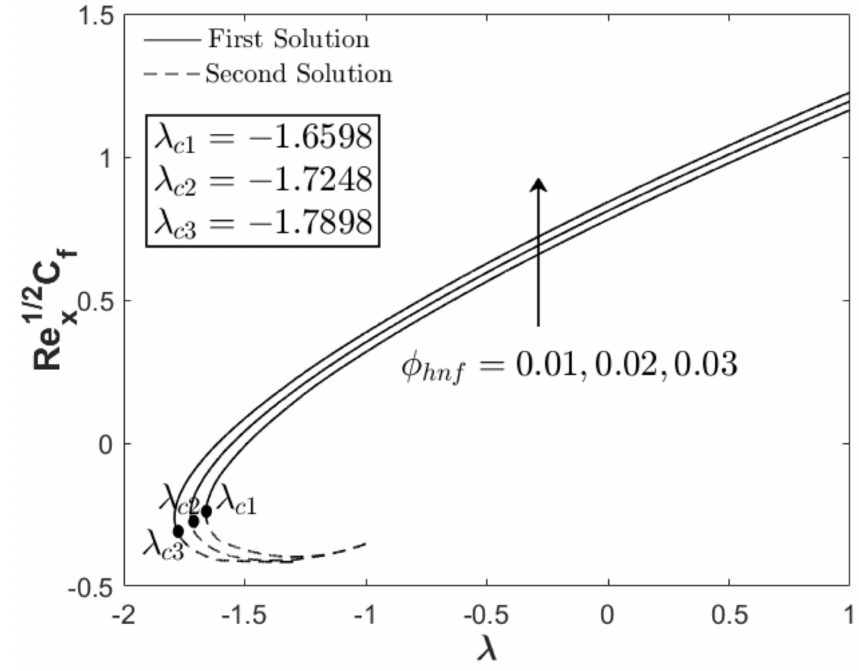
Figure 6. Re 1/2 x C f towards λ when m = 0.3, S = 0.05, and different φ hnf .